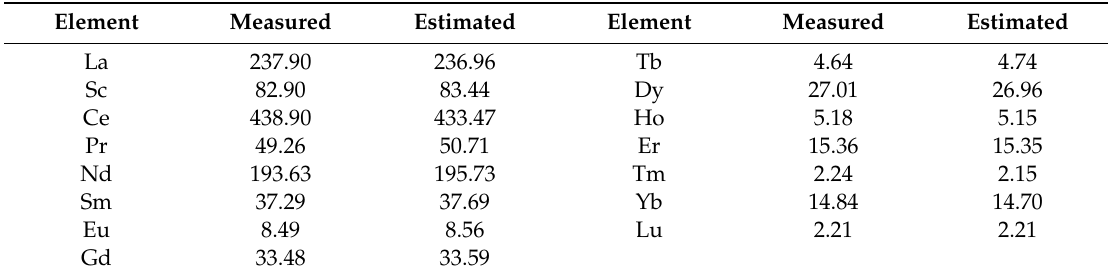
Table 5. Results of linear mixing modelling.